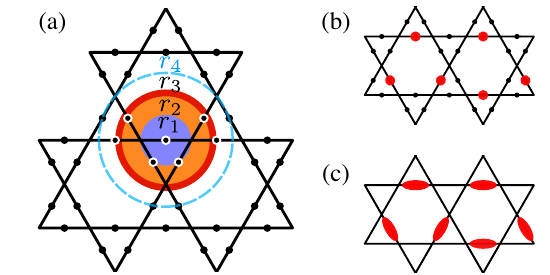
FIG. 1. Rydberg blockade model and relation to dimer